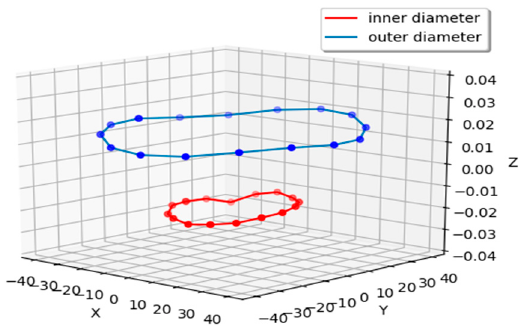
Figure 8. Example of experimental surface flatness results for measuring points (see Figure 1) for reference elements (blue color—before heat treatment processing, red color—after heat treatment processing).